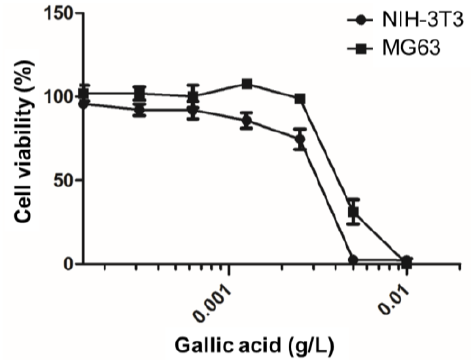
Figure 6. The viability of NIH-3T3 and MG63 co-cultured with varying gallic acid concentrations.